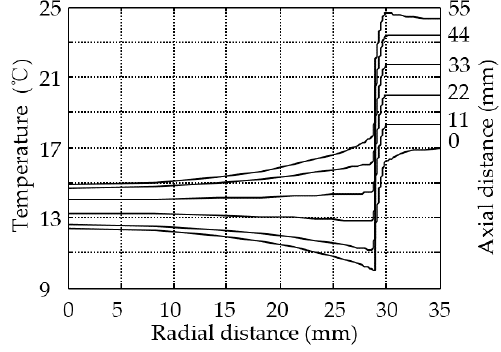
Figure 14. Temperature curves along the radial direction.